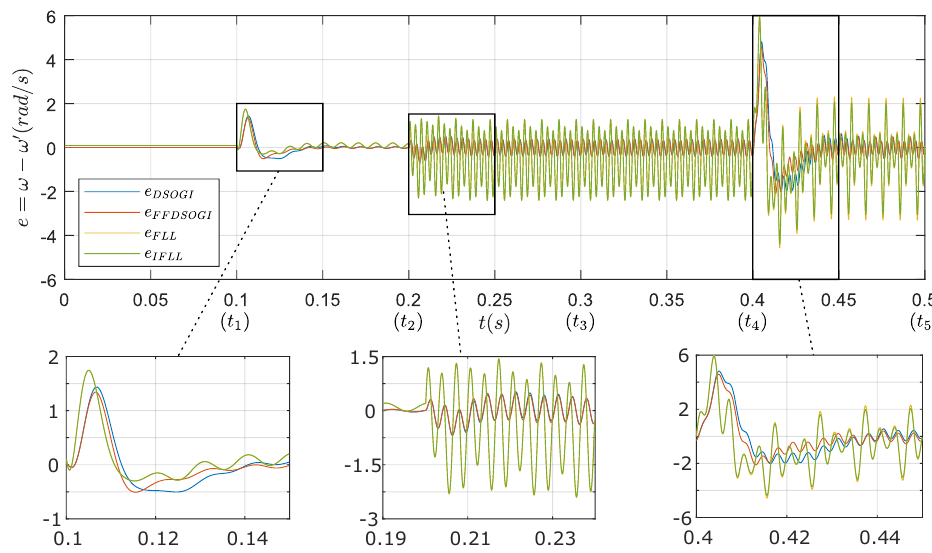
Figure 11. Estimated frequency errors for the different methods during test #1.